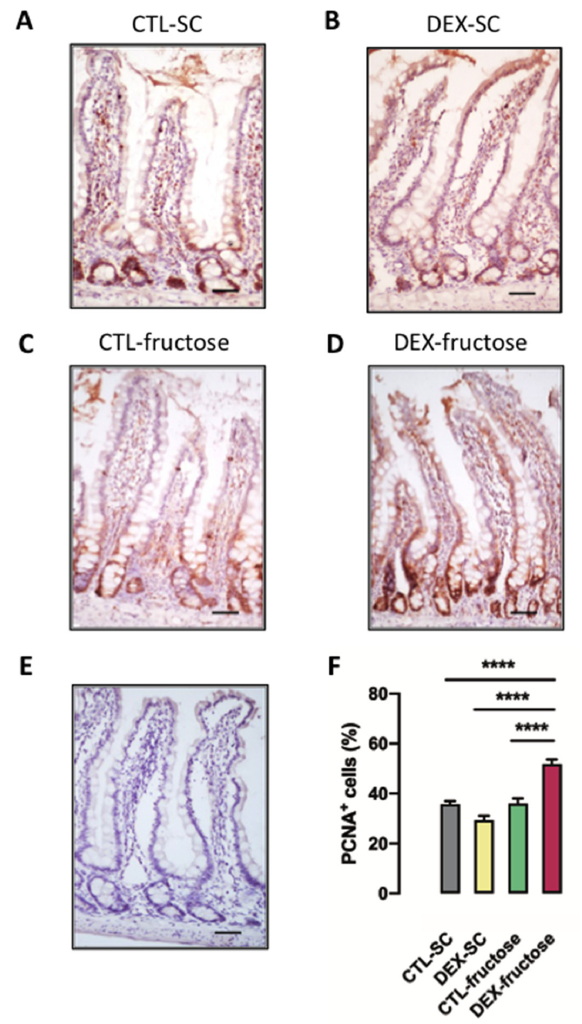
Figure 7. Jejunum was removed for immunohistochemical detection of proliferating cell